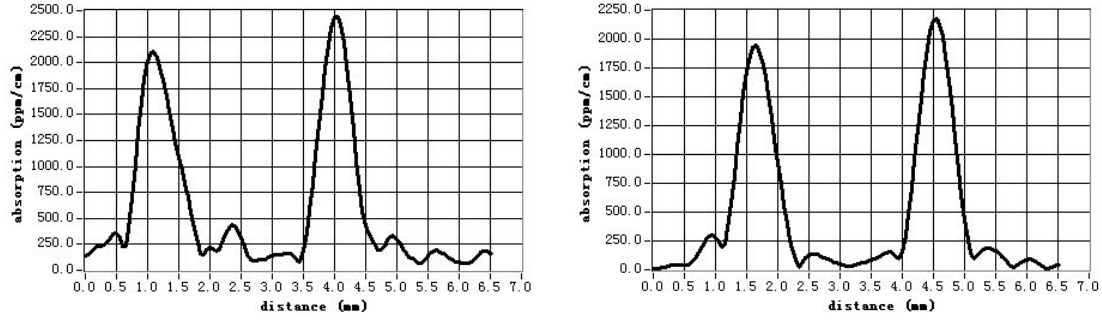
Figure 7. Weak absorption curves of 5% Al-doped CLBO crystal along ( left ) a and ( right ) c directions. Table 2. Weak absorption values of CLBO crystals.